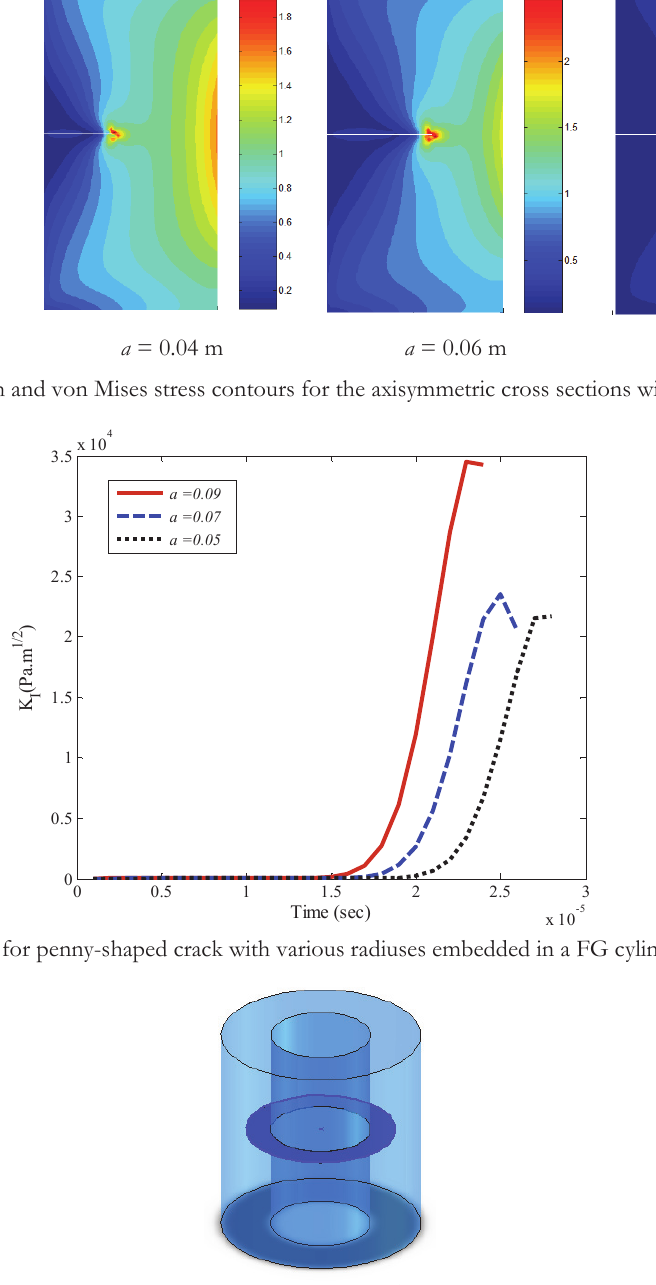
Figure 7: Schematic plot of a transparent hollow cylinder with internal circumferential